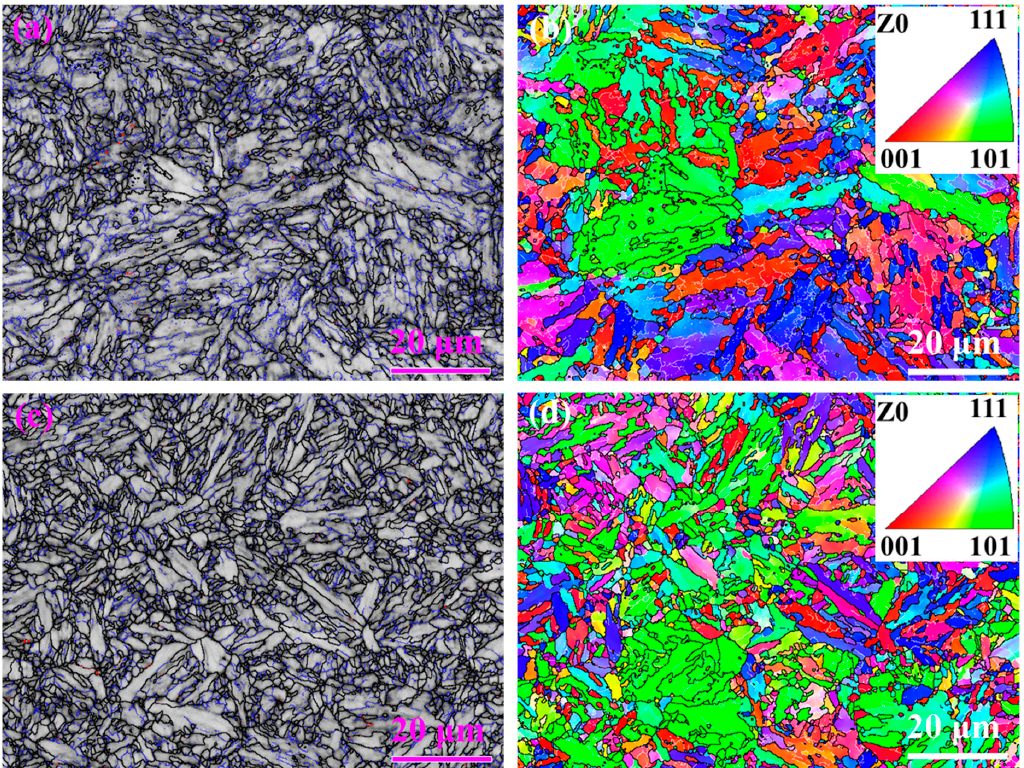
Figure 7. EBSD images: ( a ) Band Contract with RA marked and ( b ) Inverse pole figure (IPF) map of 0.12C-3.13Mn steel tempered at 600 °C for 5 h; ( c ) Band Contract with RA marked and ( d ) IPF map of S4430 steel tempered at 600 °C for 5 h. (The black line indicates high angle grain boundaries, while the fine blue line indicates low angle grain boundaries in ( a ) and ( c ). The black line indicates high angle grain boundaries, while the fine white line indicates low angle grain boundaries in ( b ) and ( d ).).